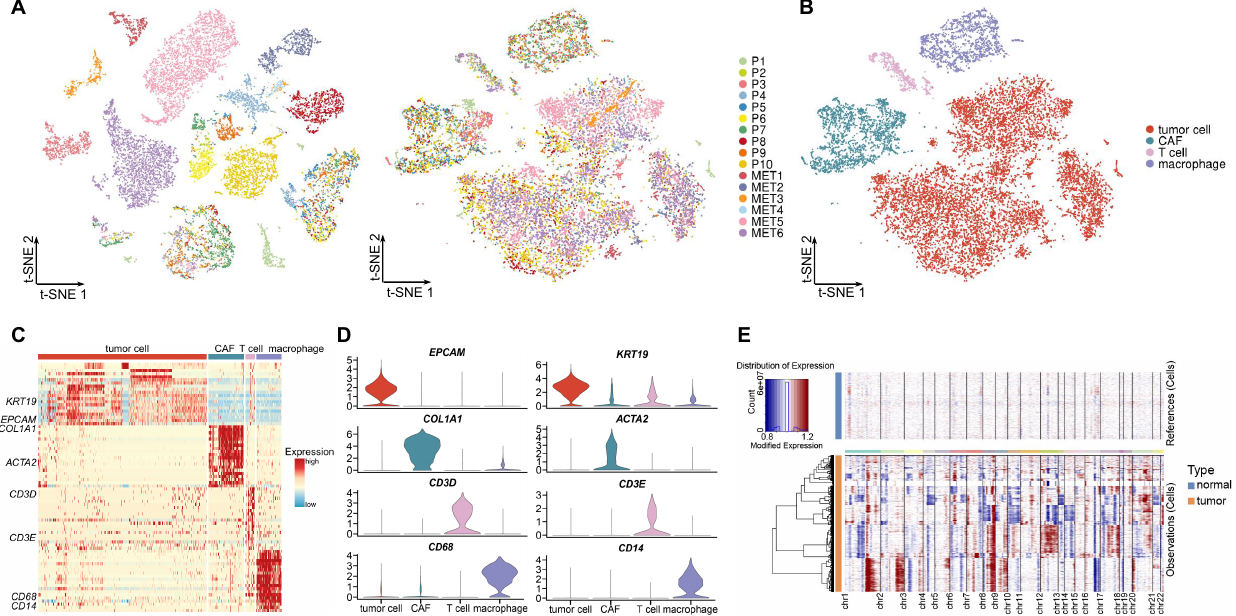
Figure 2. Cell composition of pancreatic ductal adenocarcinoma (PDAC). ( A ) t-distributed stochastic neighbor embedding (t-SNE) plot for distinct patients. Cells are colored according to patients before (left) and after (right) integration. ( B ) t-SNE plot of 4 major cell types identified in primary and metastatic PDAC. ( C ) Heatmap of specific markers in each cell type. ( D ) Violin plots of expression for well-known markers. The y -axis shows the expression level. ( E ) Heatmap of inferred copy number variation (CNV) across normal epithelial cells and tumor